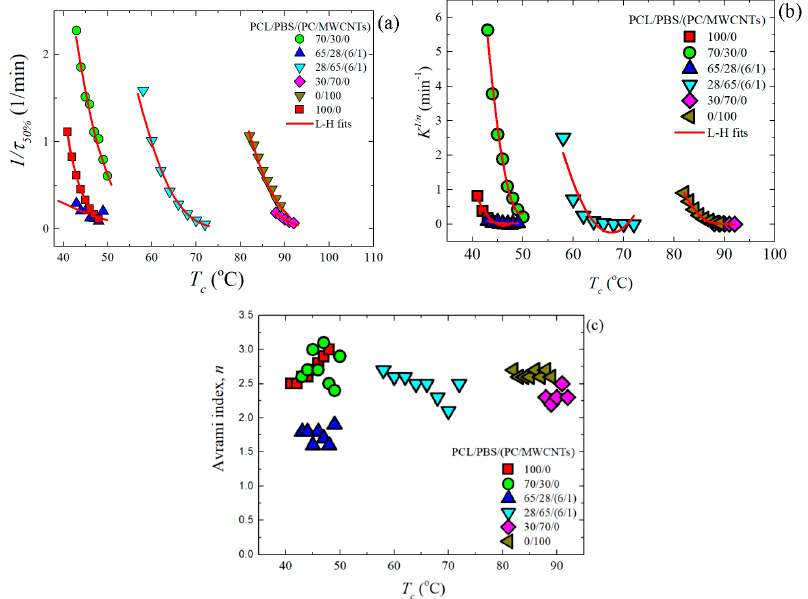
Figure 7. ( a ) Inverse of half crystallization times (1 / t 50% ): ( b ) normalized crystallization constant of the Avrami model ( K 1 / n ), and ( c ) Avrami index ( n ) as a function of the isothermal crystallization temperature ( T c ) for all the samples. The red solid lines represent fits to the LH theory.